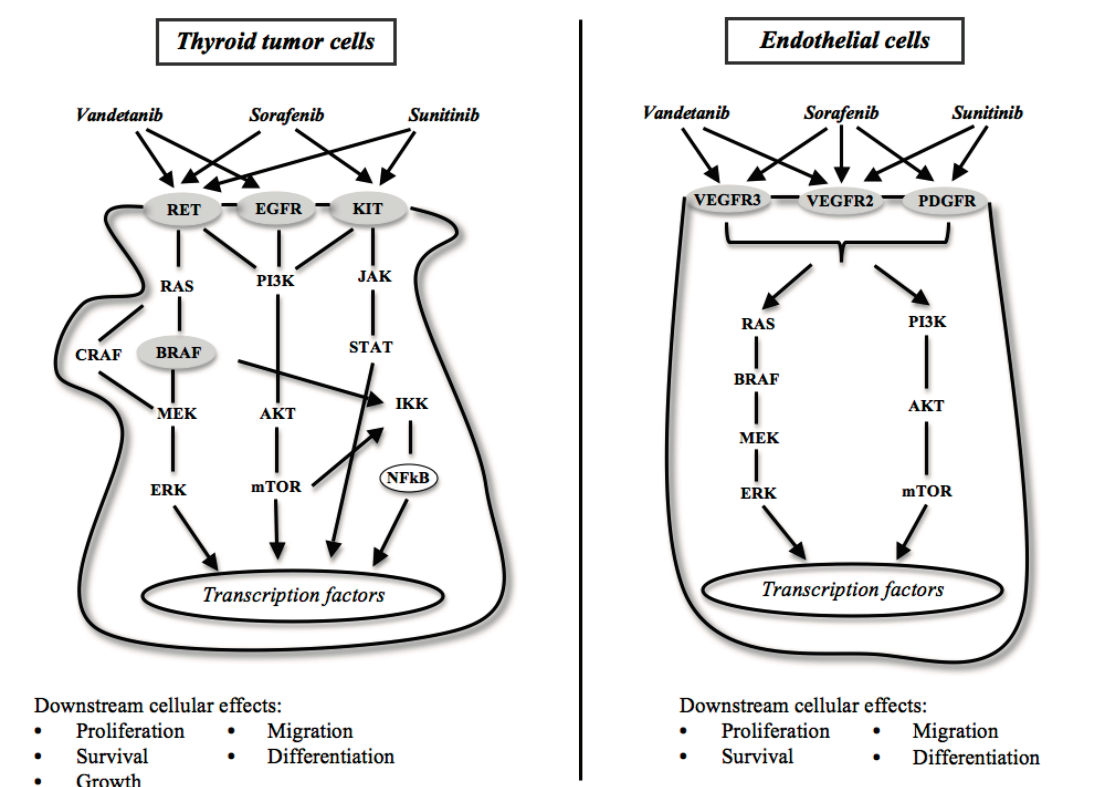
Figure 1. Molecular targets and tyrosine kinase inhibitors in the signaling pathways involved in dedifferentiated papillary thyroid